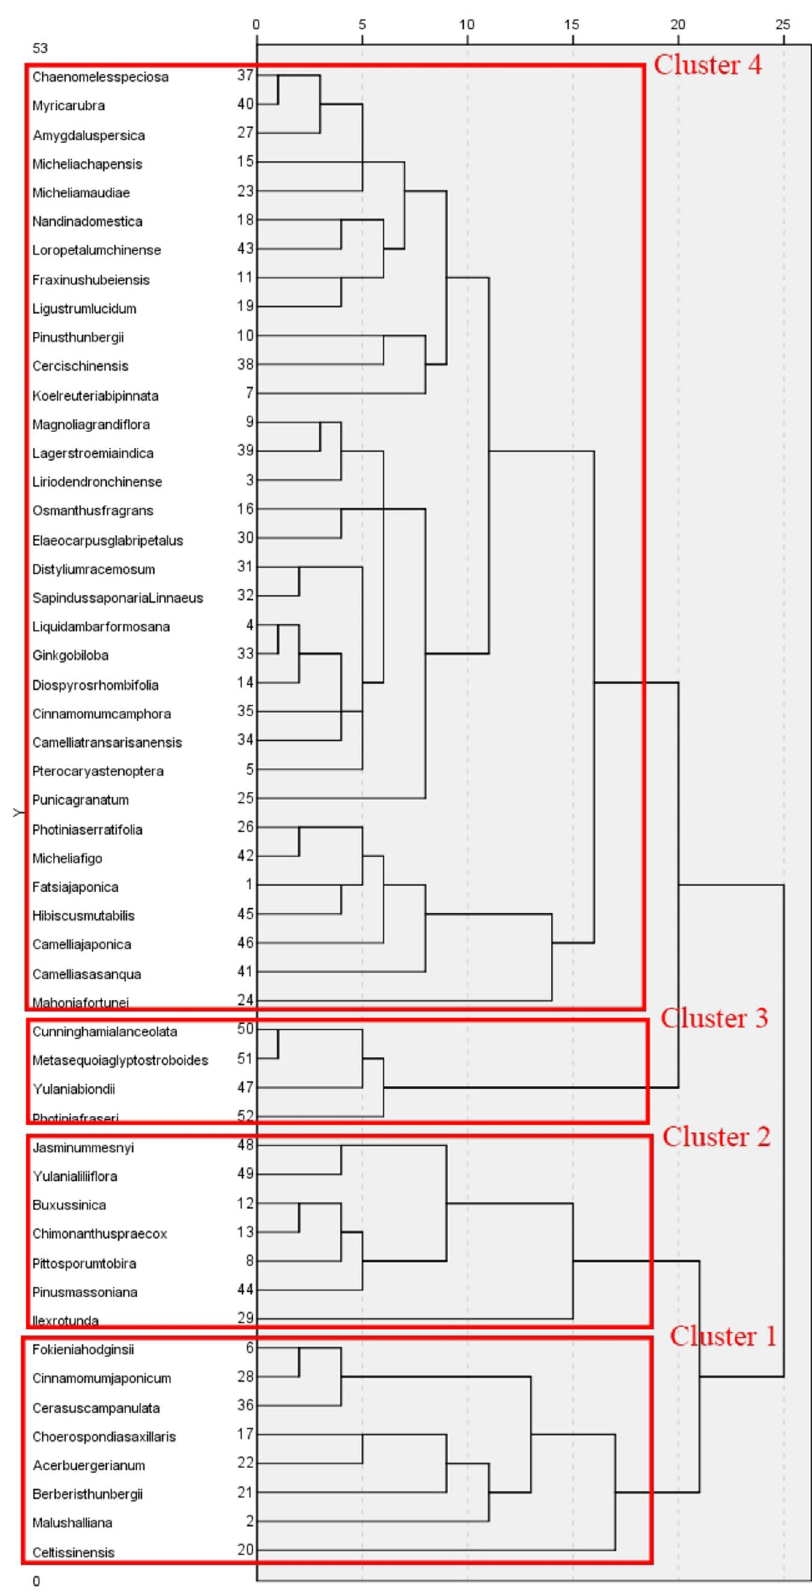
Figure 14. Clustering analysis of number of